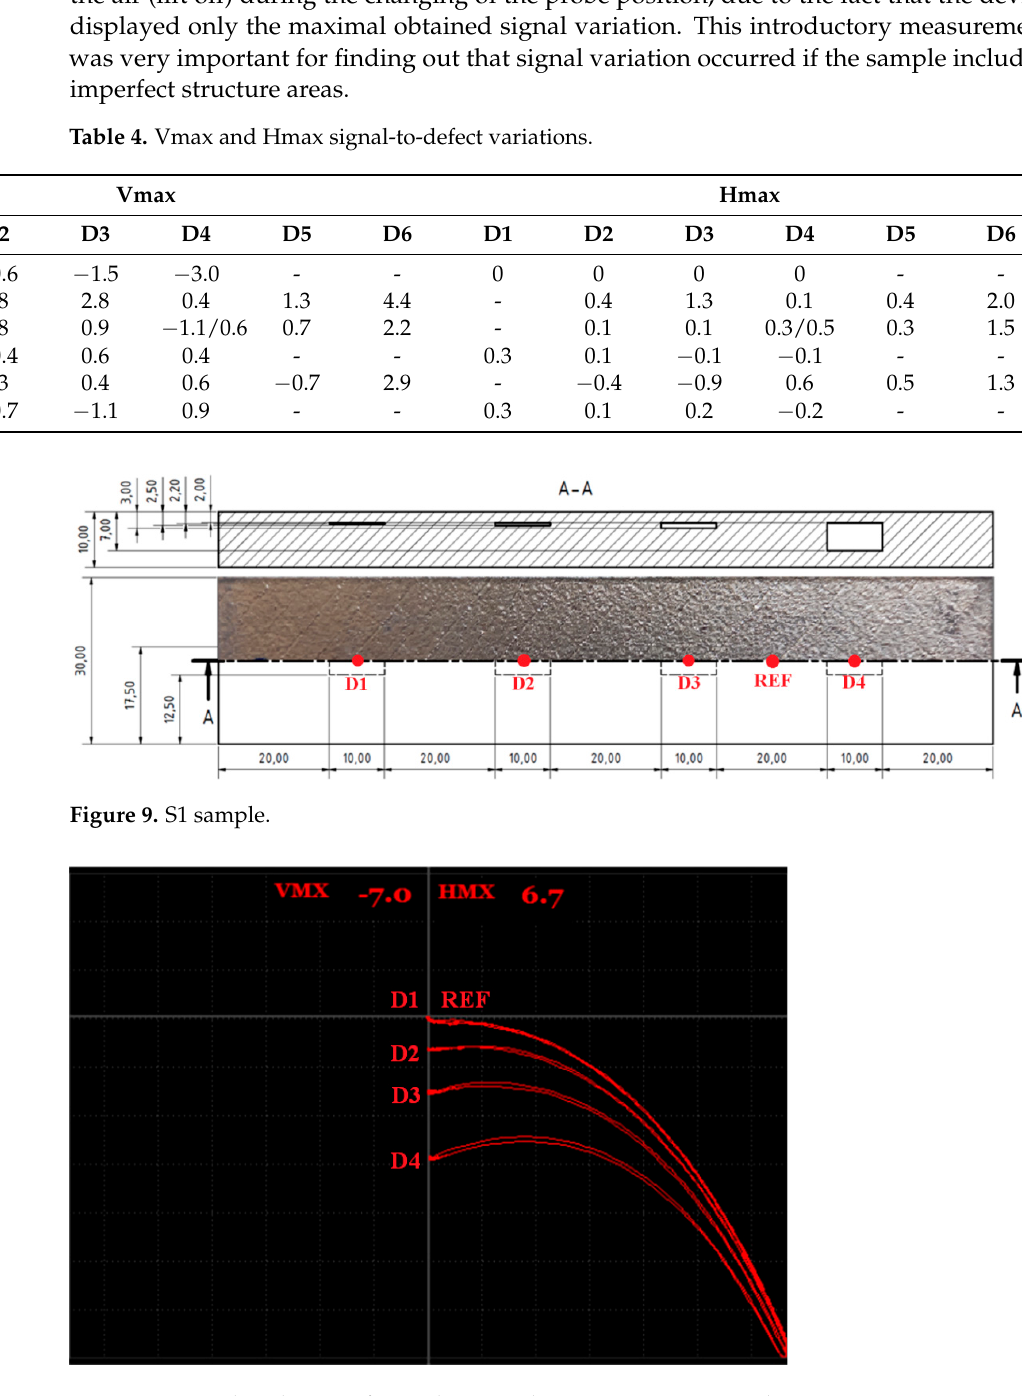
Figure 10. Signal-to-density of unmolten powder variation in S1 sample.